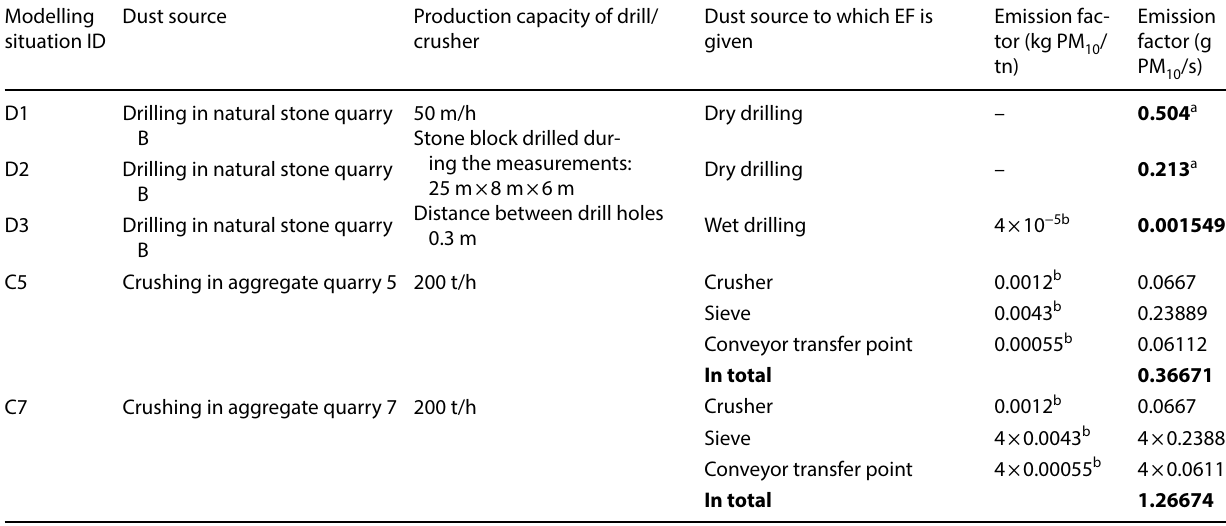
Table 2 Modelled situations and respective emission factors (EFs)